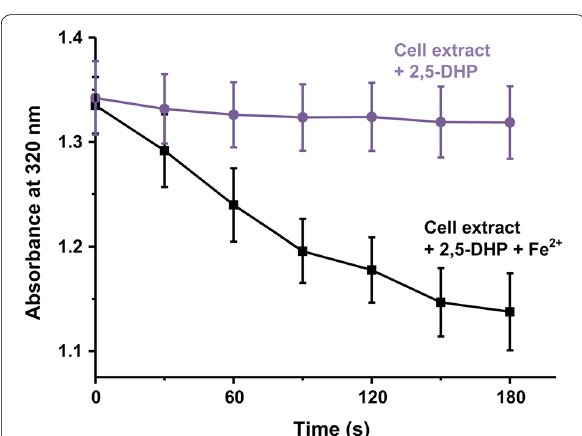
Fig. 7 2,5-Dihydroxypyridine transformation by cell extract of strain DW-1. The reaction volume was 800 μL, in which 300 μL cell extract of strain DW-1 was mixed with 250 μM 2,5-dihydroxypyridine with or without 5 μM FeSO